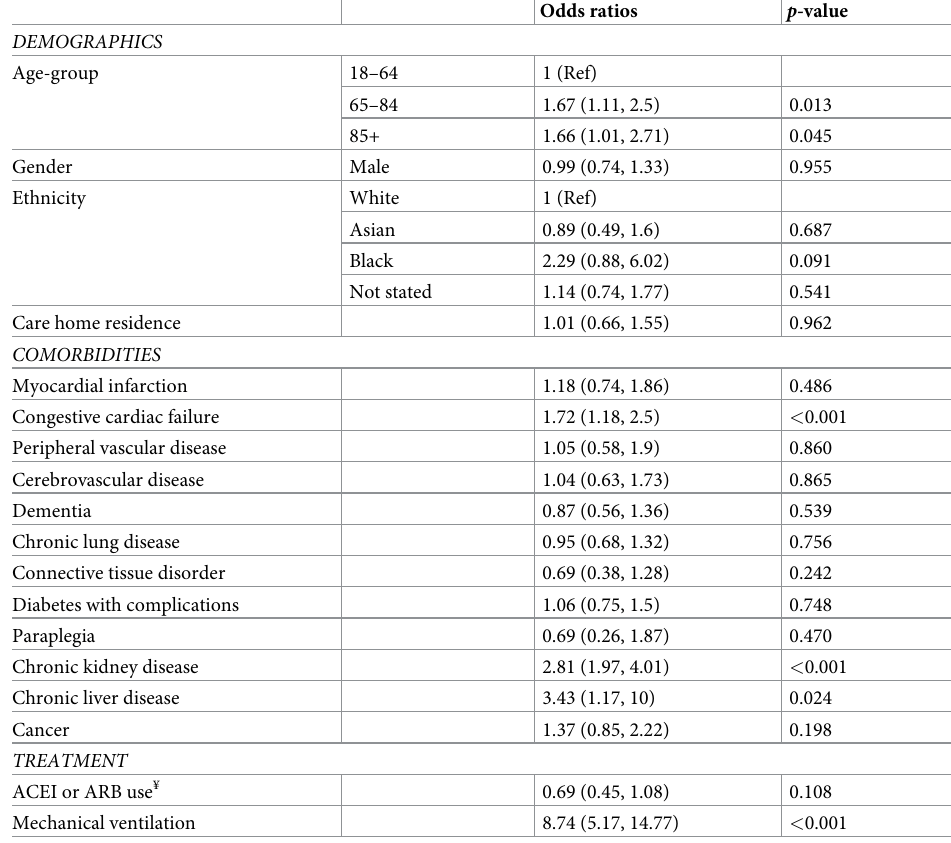
Table 2. Multivariable logistic regression to identify risk factors for AKI in COVID-19